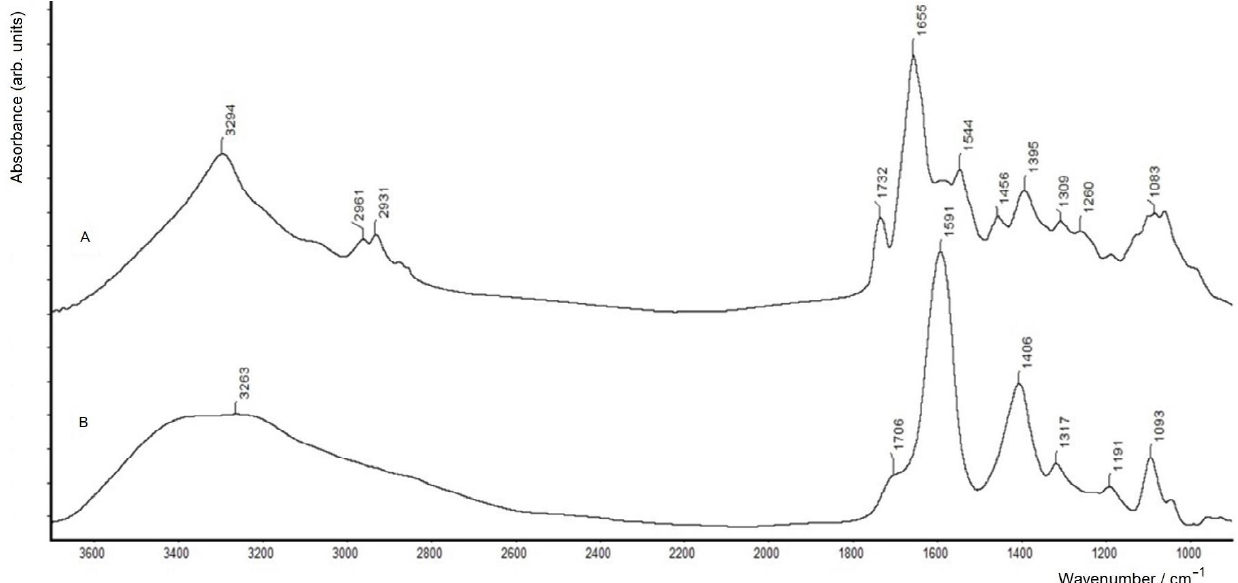
Figure 1. FTIR spectra of ( A ) an A. baldaniorum Sp245 biofilm formed on the surface of a ZnSe glass disc (washed one time and dried) and ( B ) a thin dry film of the culture liquid (SMS) measured in the transmission mode on a ZnSe glass disc.